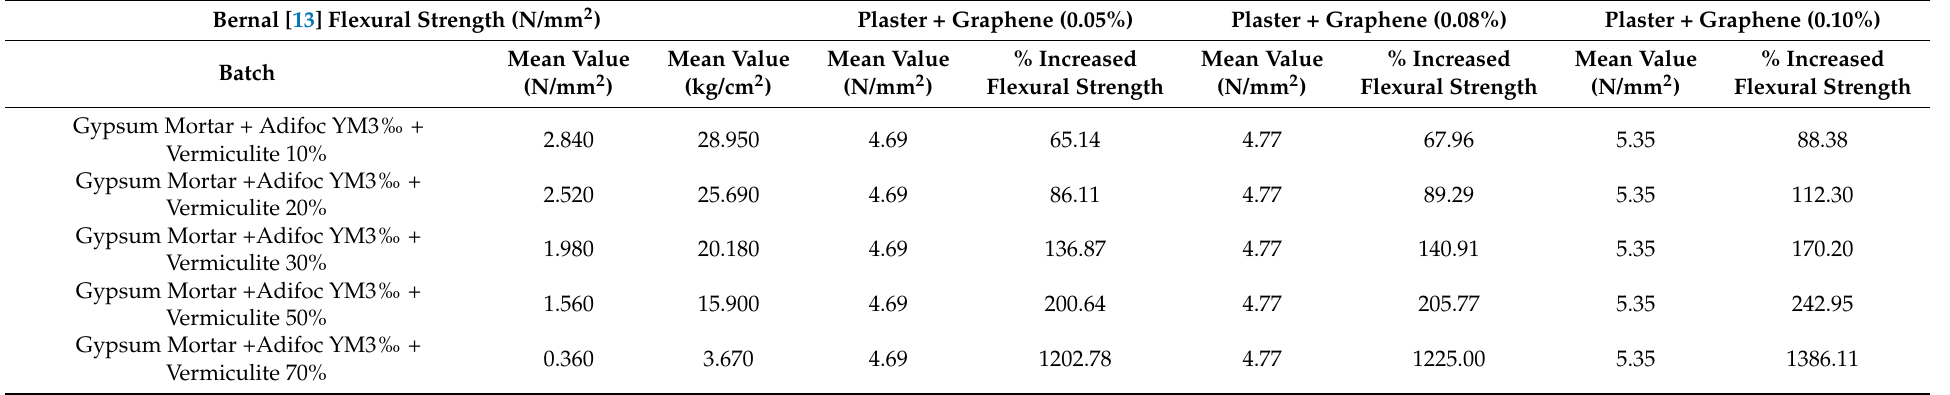
Table 8. Comparison of bending strength test results of gypsum mortar with added graphene powder with respect to the research results obtained by Bernal [13]. Bernal [13] Flexural Strength (N/mm 2 )